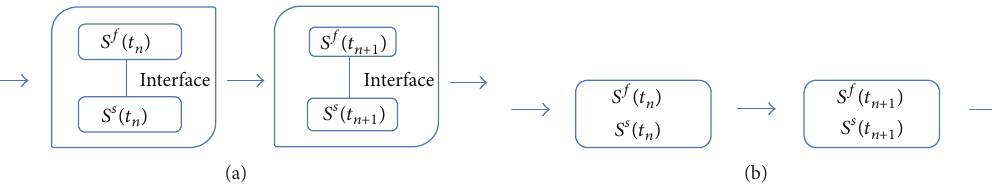
Figure 3: Schematic of (a) partitioned approach and (b) monolithic approach [27].